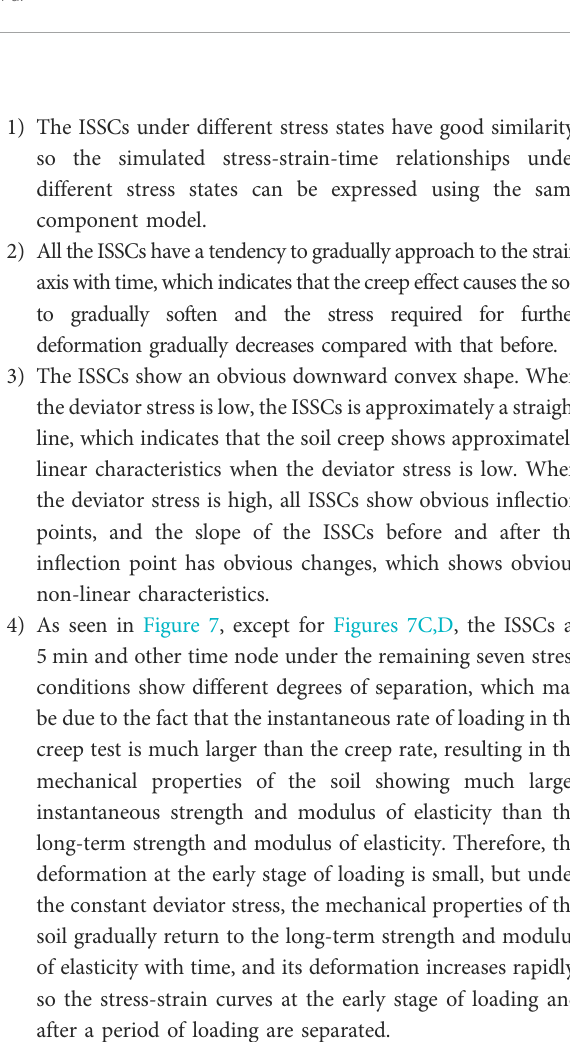
FIGURE 5 Soil bulging deformation of sample 3 after loading deviator stress q=300